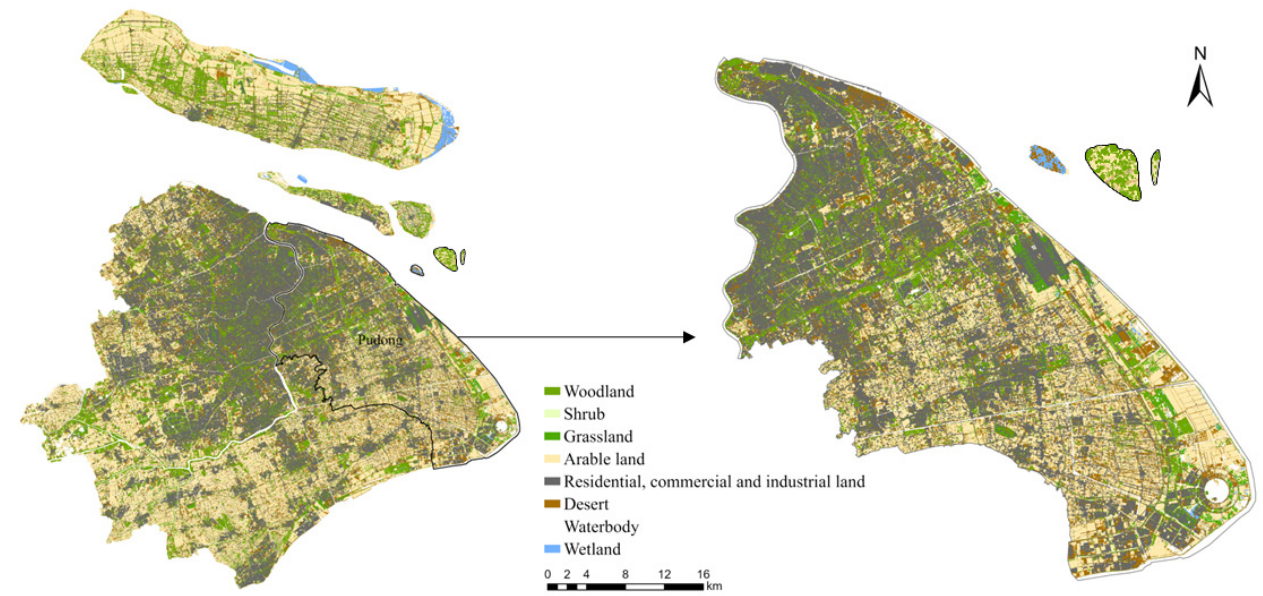
Figure 2. Distribution of land use types in Pudong New Area.